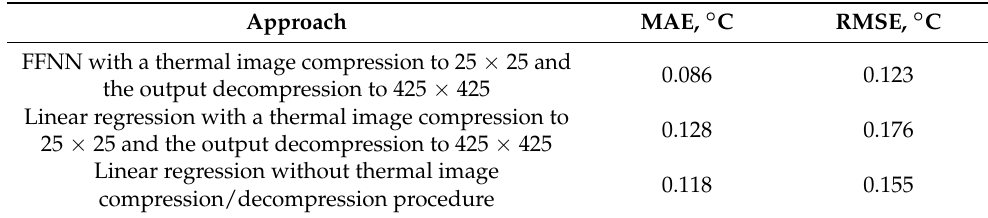
Table 1. RMSE and MAE metrics depending on the used ML algorithm and the thermal image compression